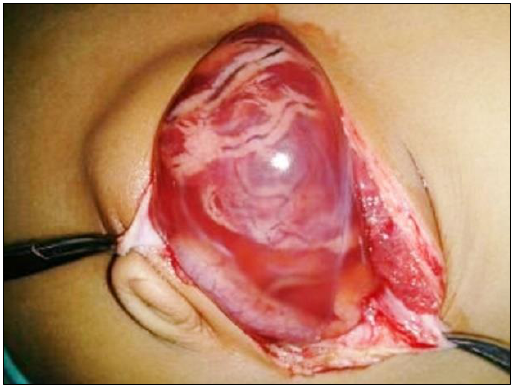
Figure 1: Ruptured umbilical